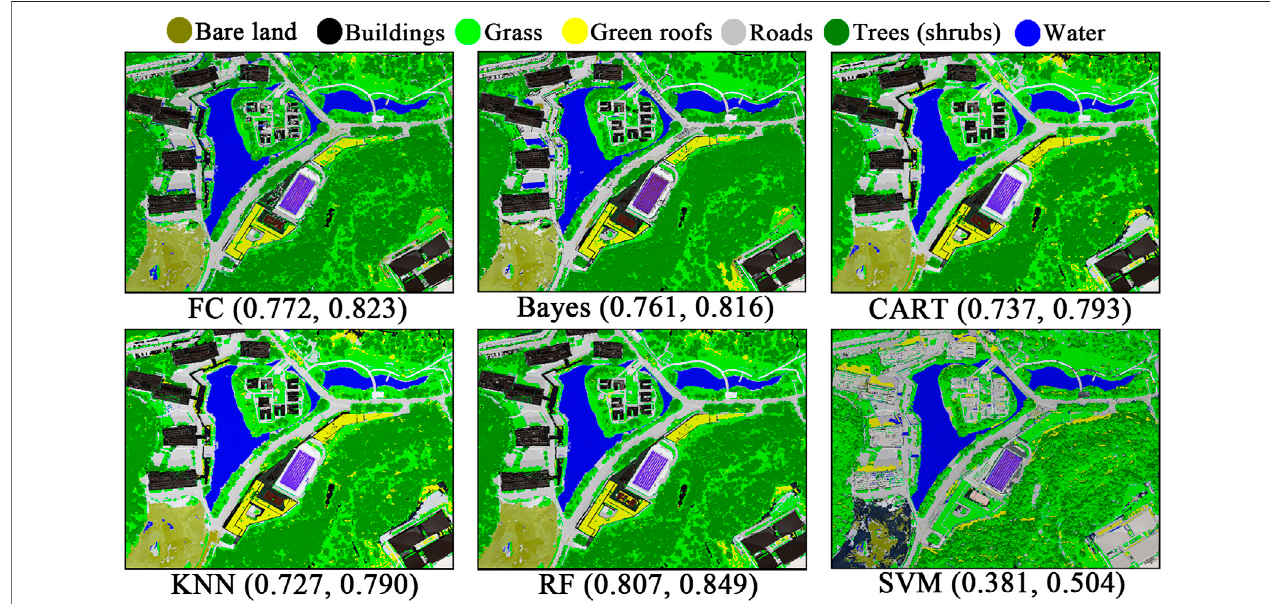
FIGURE 5 | Results for the classi fi cation algorithms and their kappa coef fi cients and OAs.